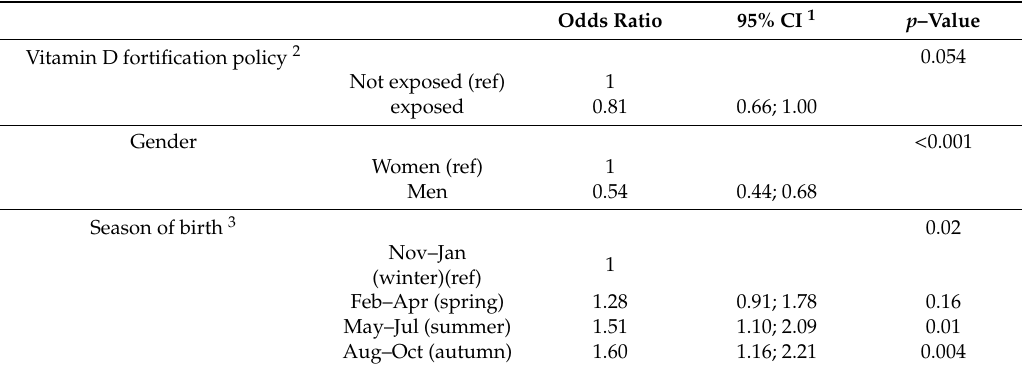
Table 2. Risk of coeliac disease among those prenatally exposed to extra vitamin D and dependent on season of